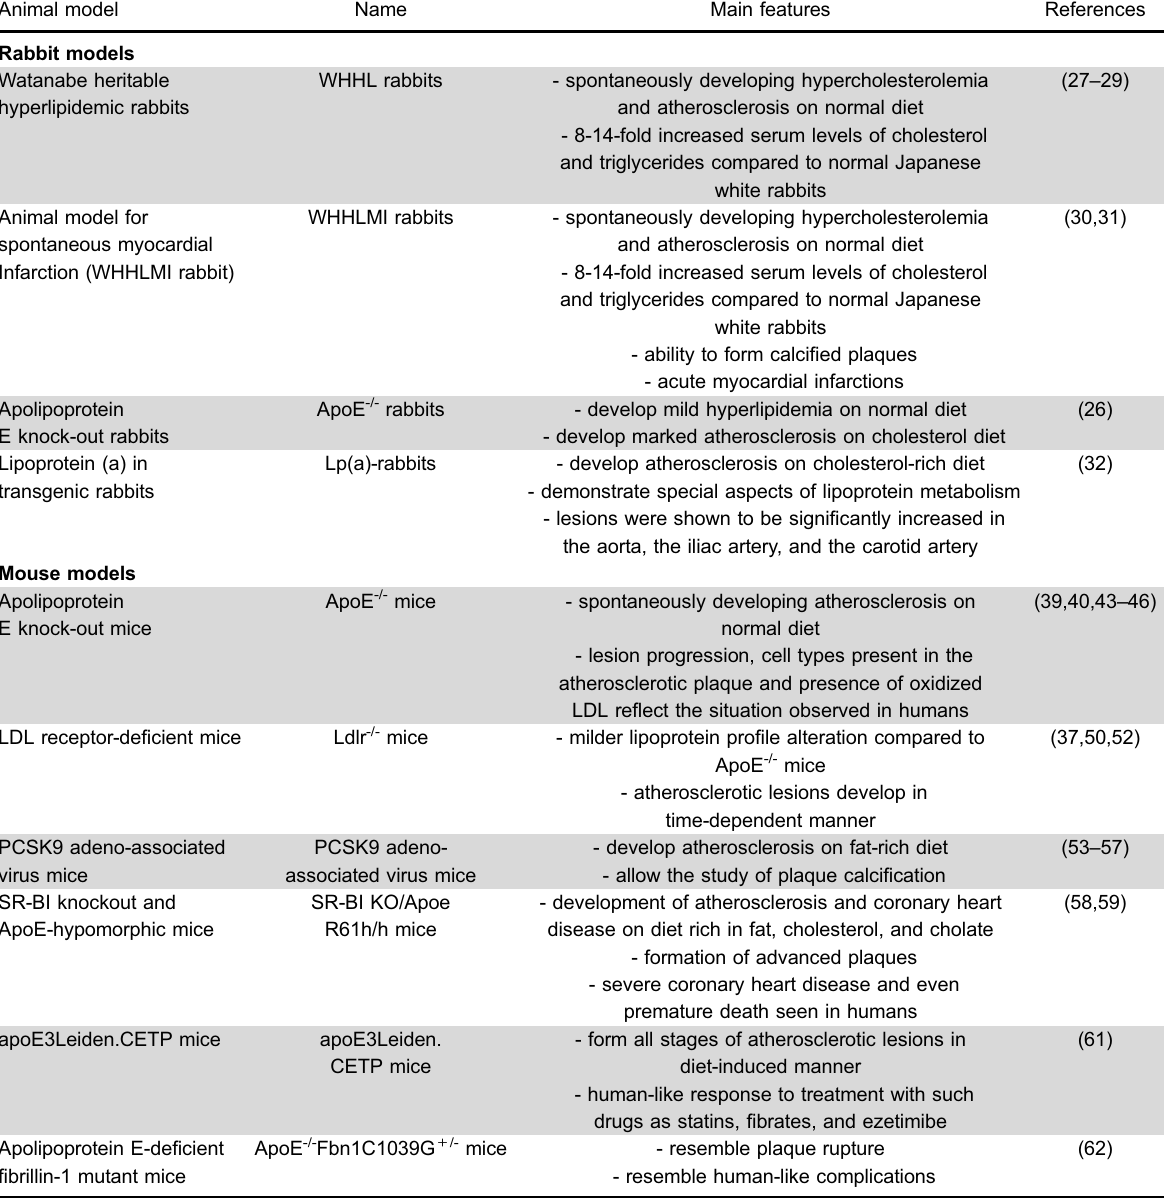
Table 1. Overview of rabbit and mouse models of human atherosclerosis. Animal